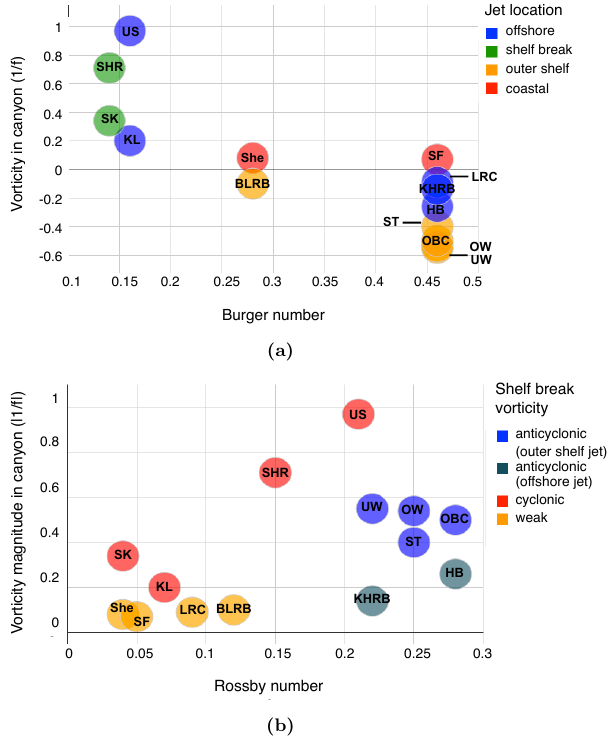
Figure 12. Effect of (a) Burger number and (b) incoming Rossby number on canyon vorticity for all model